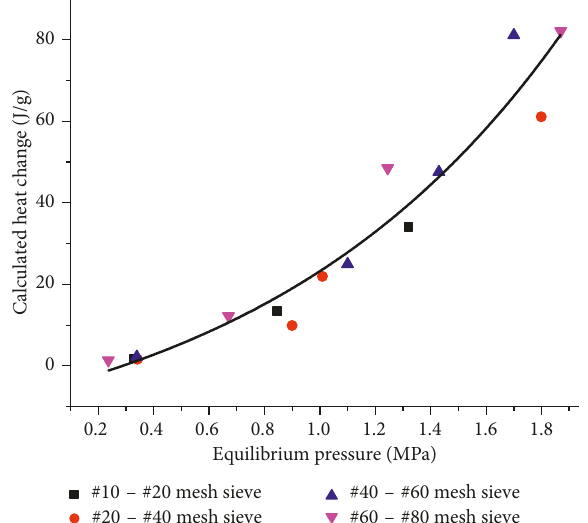
Figure 4: Theoretical desorption heat values of Zhenxing coal.